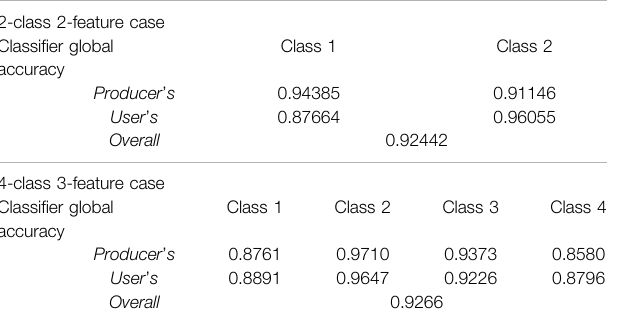
TABLE 5 | Classi fi er global accuracies of individual classes achieved by using the Bayes classi fi er in the two-class, two-feature (2C2F) case and the four-class, three-feature (4C3F) case.